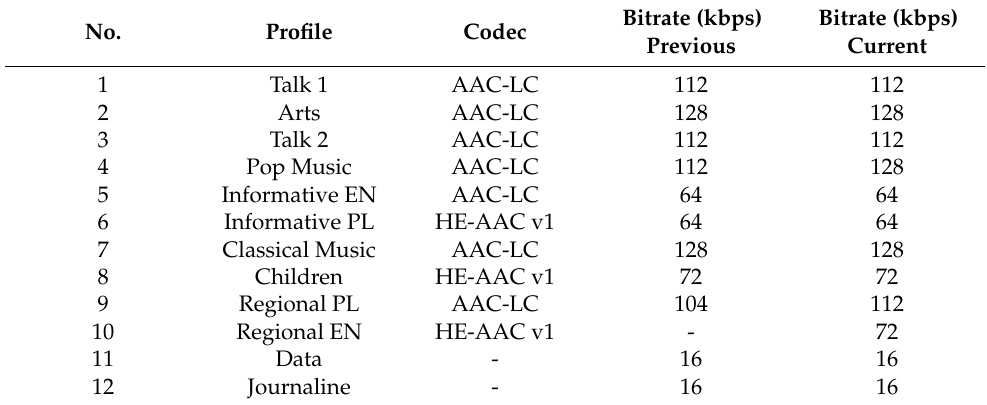
Table 6. Evaluated DAB+ multiplex